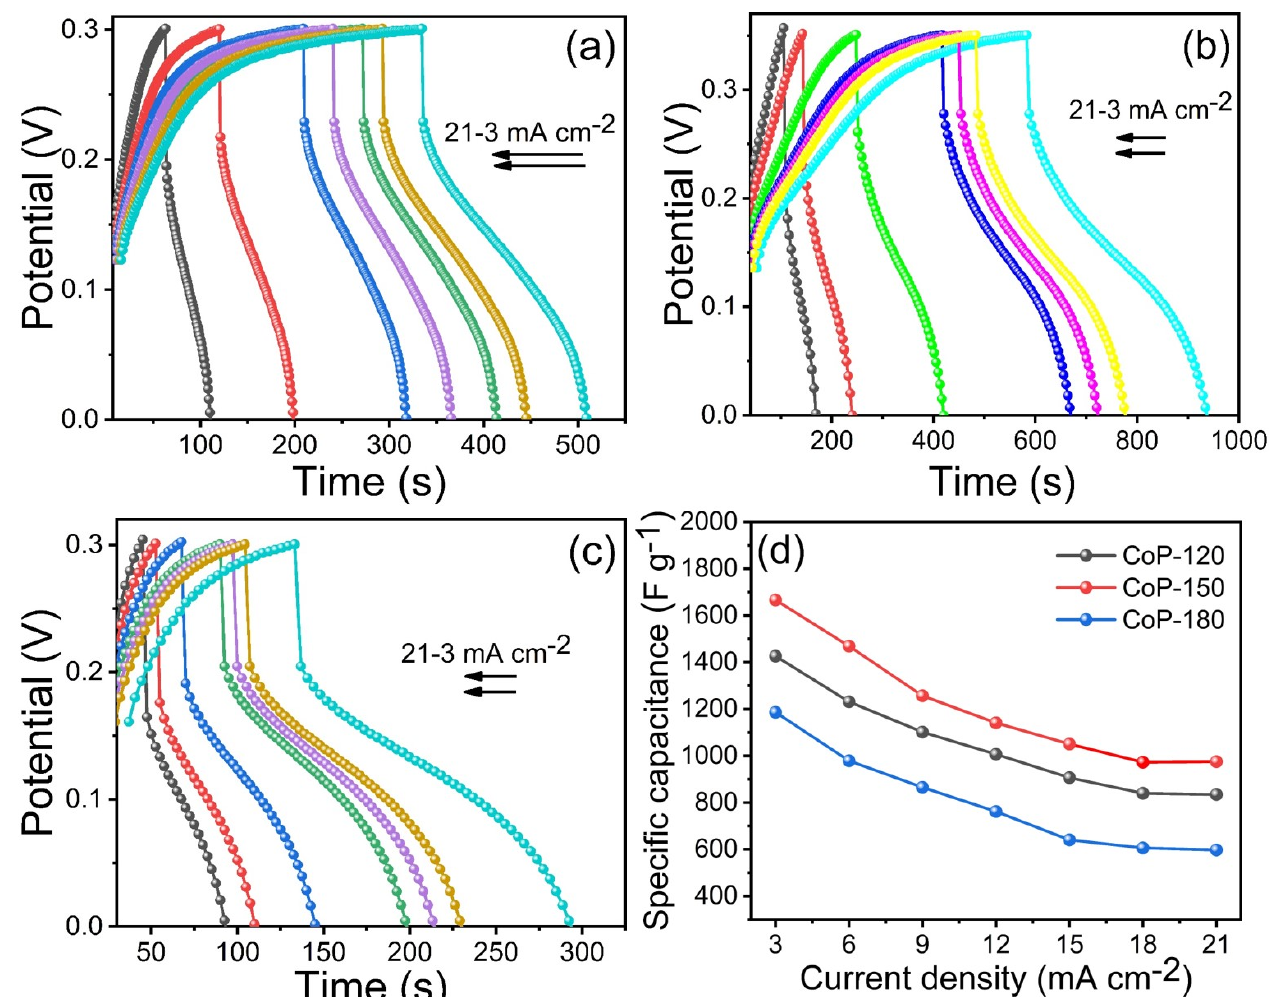
Figure 6. ( a – c ) GCD measurements of the CoP-120, CoP-150, and CoP-180 electrodes at different current densities from 3–21 mA cm − 2 , ( d ) specific capacitance of the CoP-120, CoP-150, and CoP-180 electrodes at different current densities, respectively.